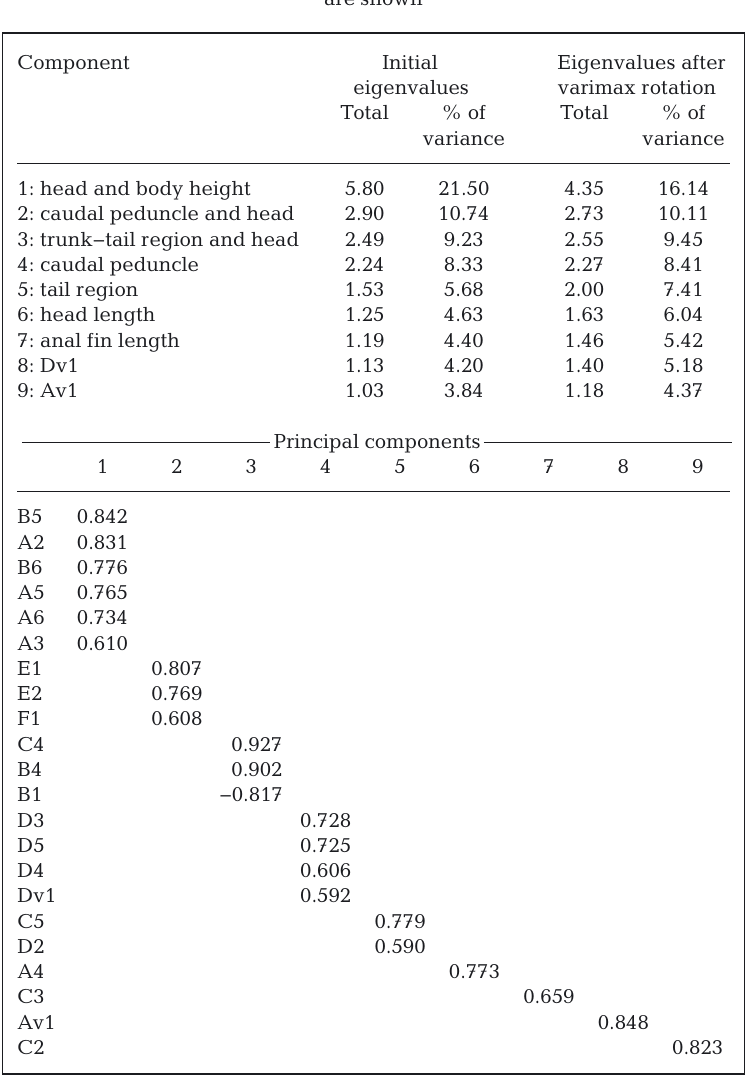
Table 3. Sparus aurata . Principal component analysis (PCA) with total vari- ance explained (%), eigenvalues and component loadings for each